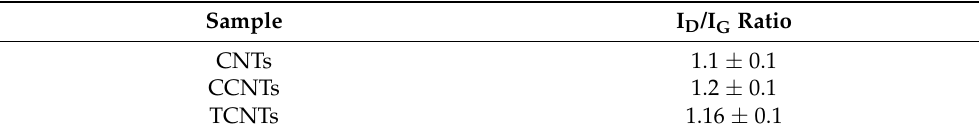
Table 3. I D /I G ratios obtained from the Raman spectra of CNTs, CCNTs, and TCNTs.